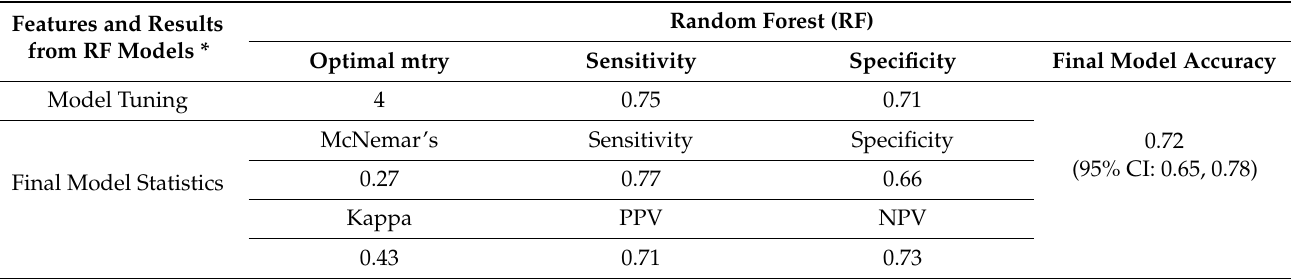
Table 4. Predictive statistical and model tuning parameters of the random forest analyses presented in Figure 3 that interrogated LFT (relative deviation) data for the best predictors of NATA class (High or Low Minor Condition